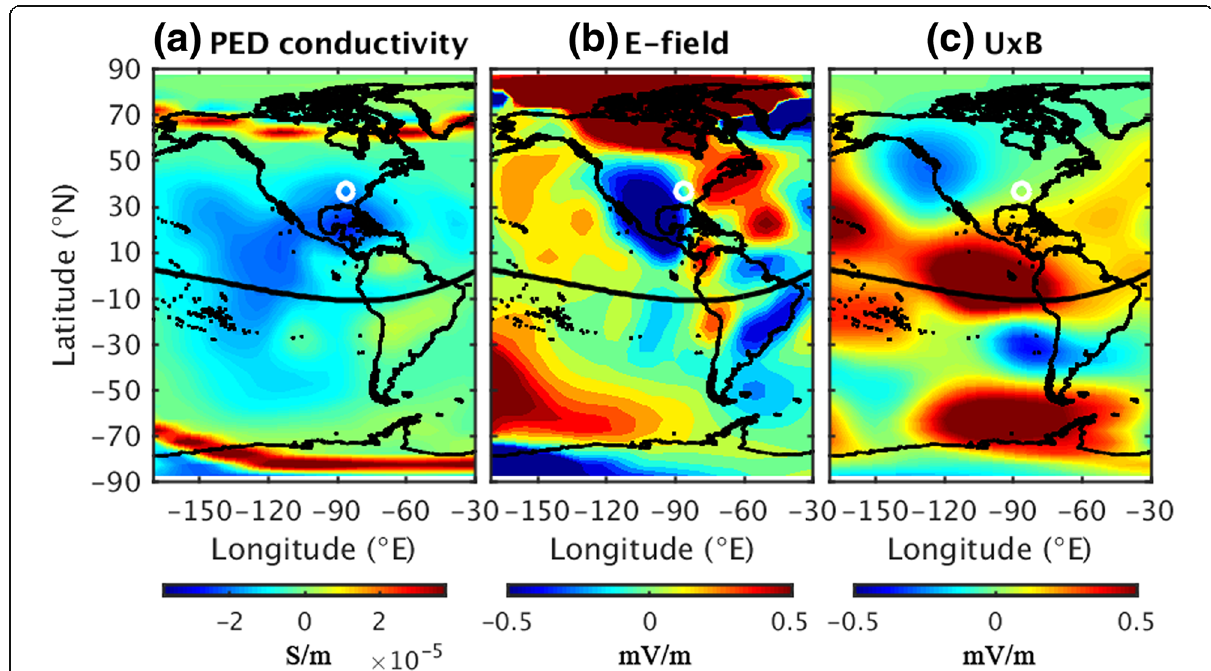
Fig. 5 The spacial perturbations between the eclipse day and the previous day at 1830 UT and 110 km altitude. There are a Pedersen conductivity, b eastward electric field, and c meridional wind effect ( U